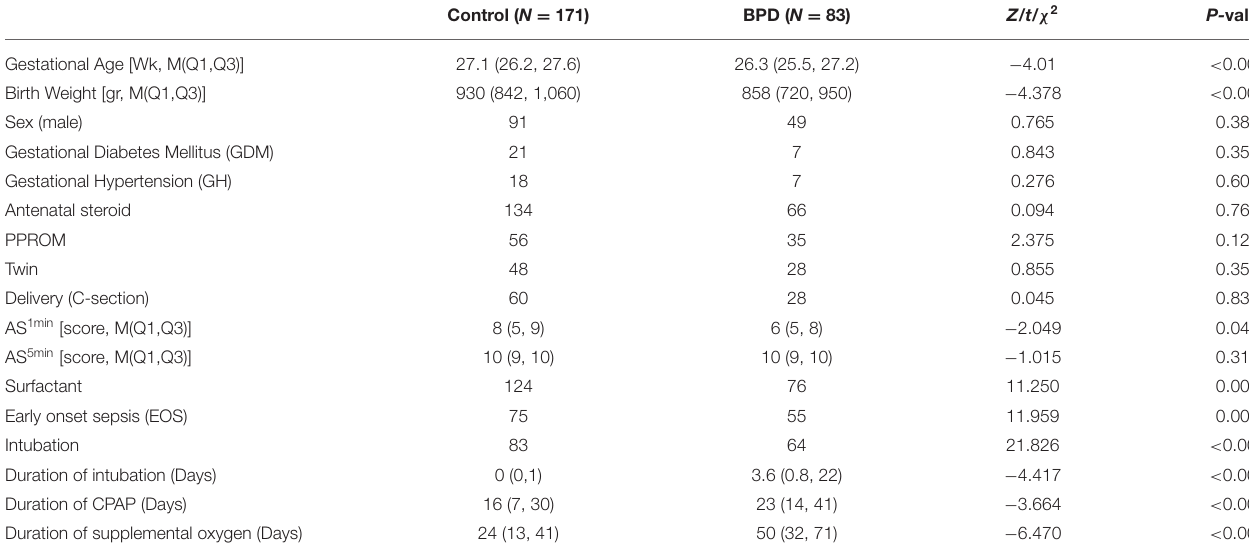
TABLE 1 | Clinical characteristics of 254 extremely premature infants by BPD status. Control ( N = 171) BPD ( N =